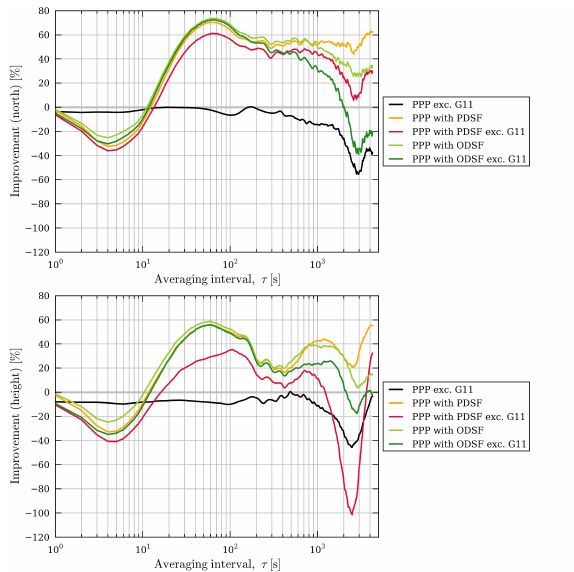
Figure 12: Figure showing the percentage improvement (i.e. reduc- tion) in Allan deviation in northing (top) and height (bottom) for station UEL, relative to the Allan deviation values corresponding to standard PPP processing that are shown in Fig. 11.